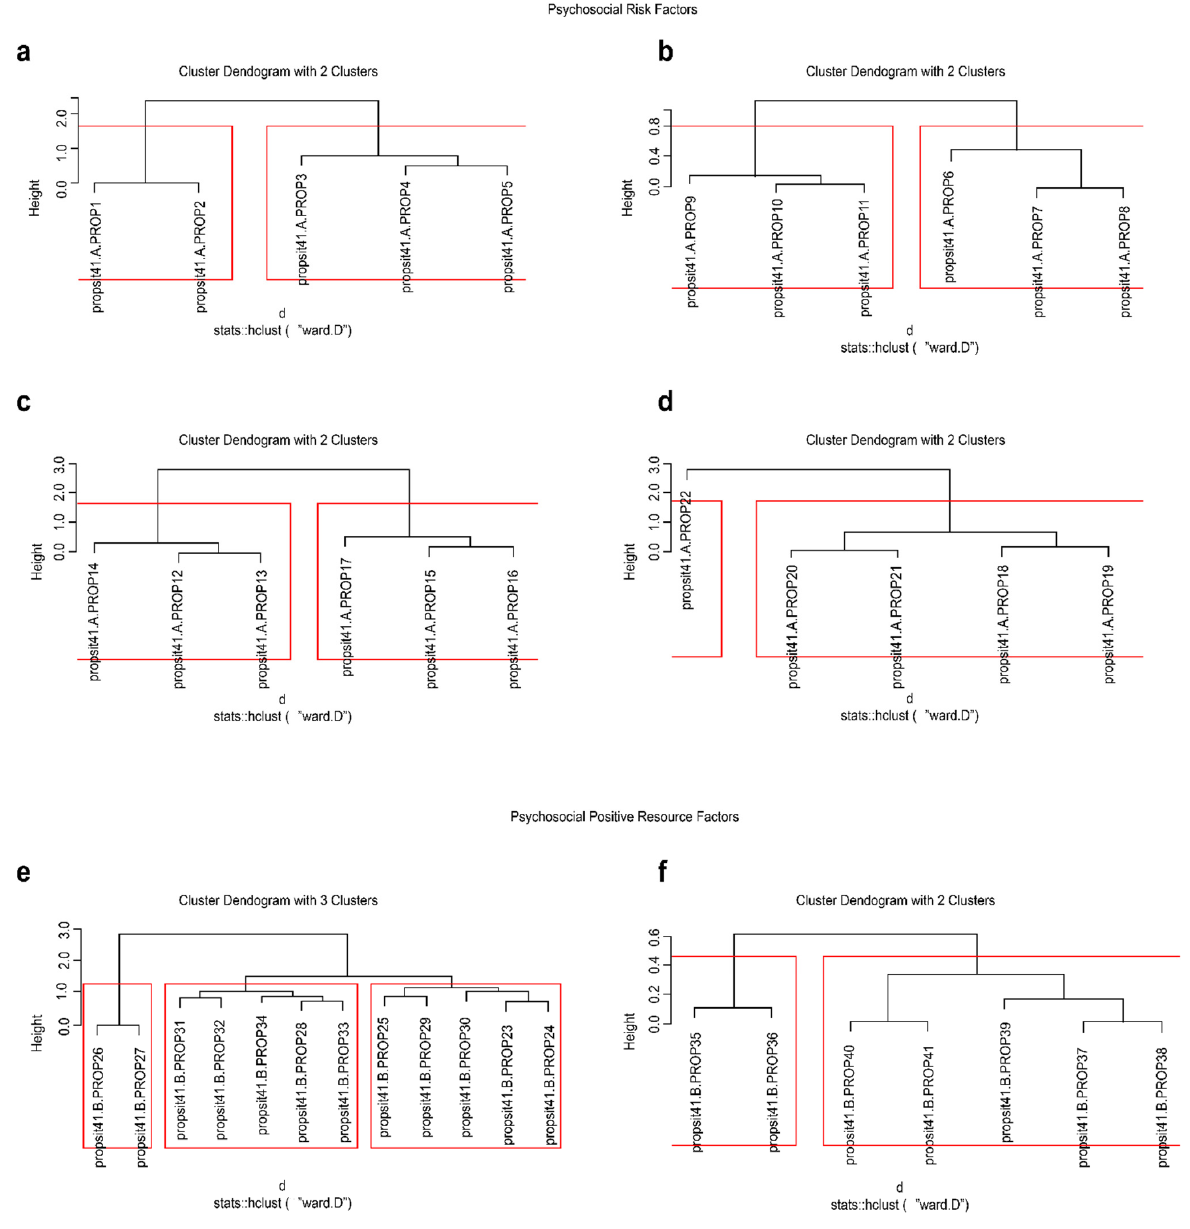
Figure 1. Dendrogram of the cluster analysis of PROPSIT items. Item sets in the figure: ( a ) (set 1,